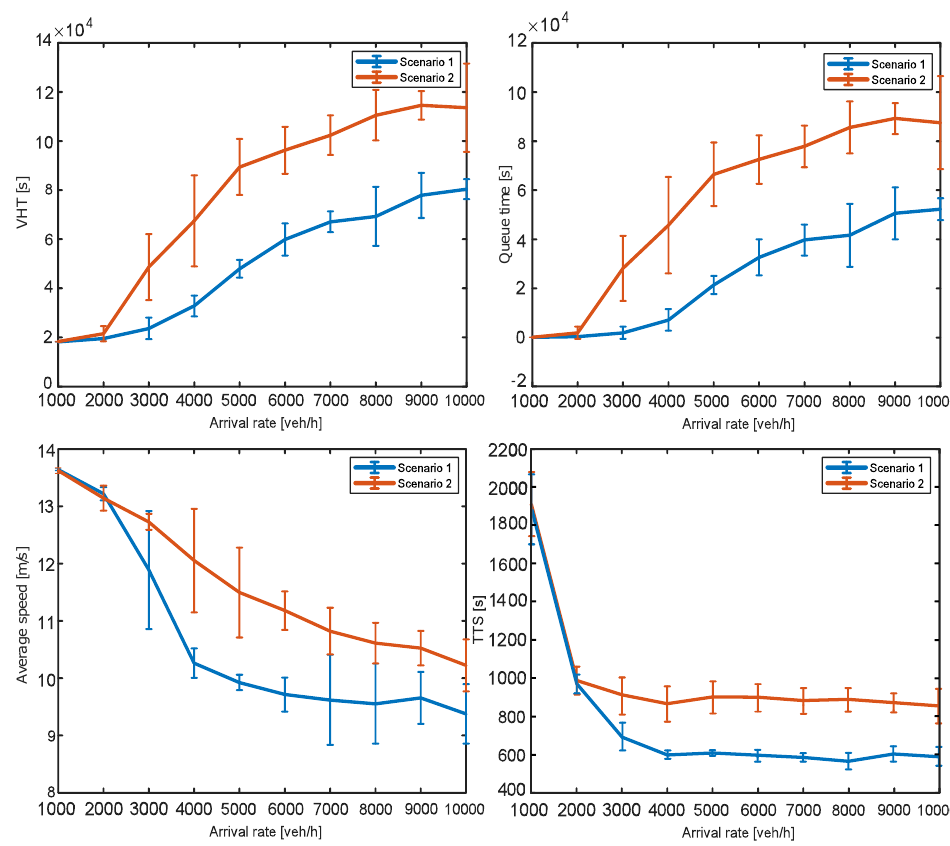
Figure 7. Simulation results for different demand